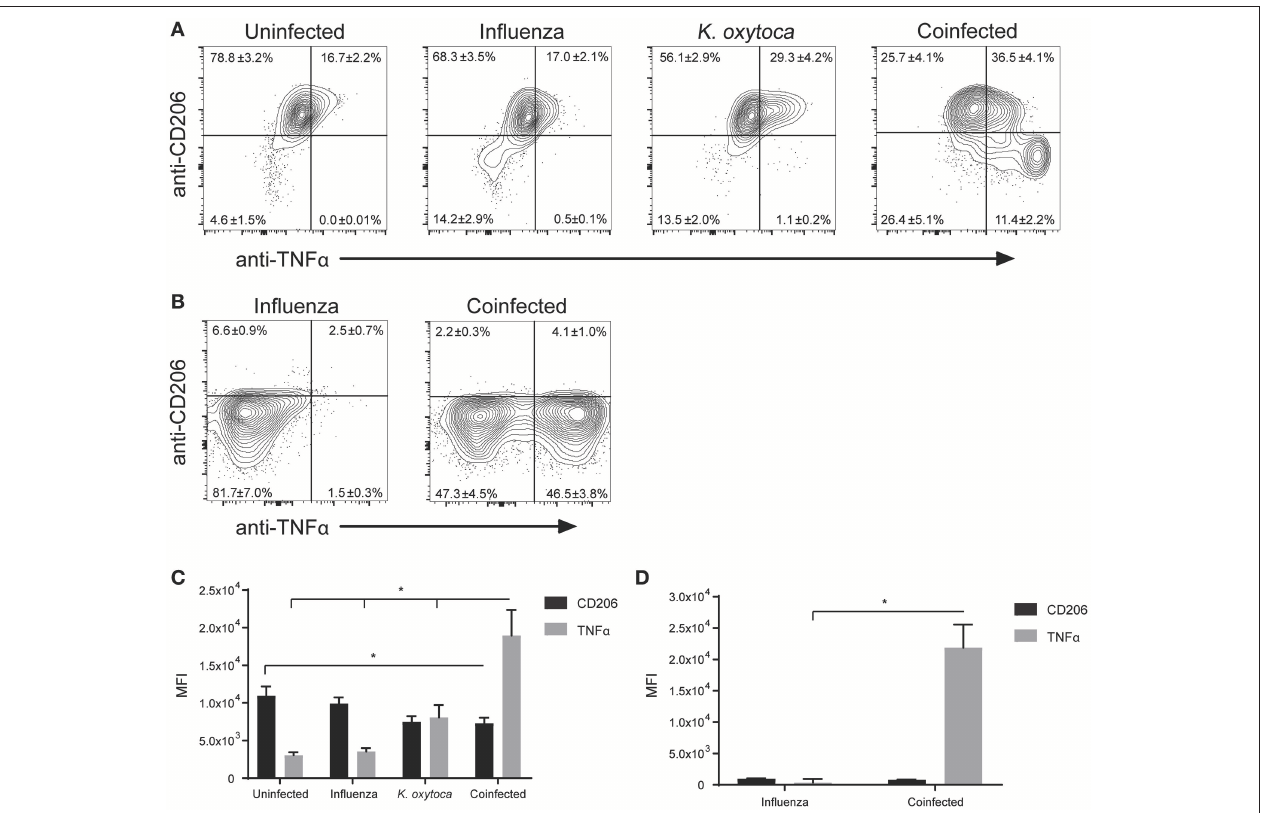
FIGURE 6 | Macrophage populations in coinfected lungs produce more TNF α than during single infections. Ly6G − F480 + CD11c + (A,C) and Ly6G − F480 + CD11c − Ly6C + MHC II + (B,D) macrophages in the BALF were analyzed on day 1 post-coinfection for expression of CD206 and production of TNF α as measured by mean fluorescent intensity (MFI). *denotes P ≤ 0.05 between indicated groups. Data were analyzed with ANOVA followed by Tukey’s multiple comparison tests. Error bars represent SEM. Data are combined from at least four independent experiments with at least four mice per group.